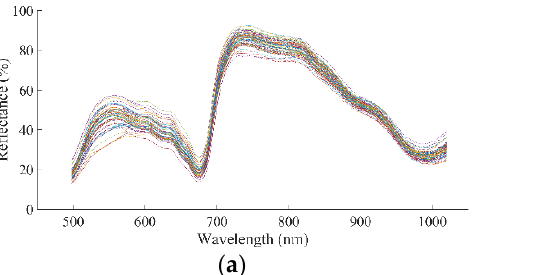
Table 3. Evaluation of PLSR based on different spectral preprocessing algorithms.